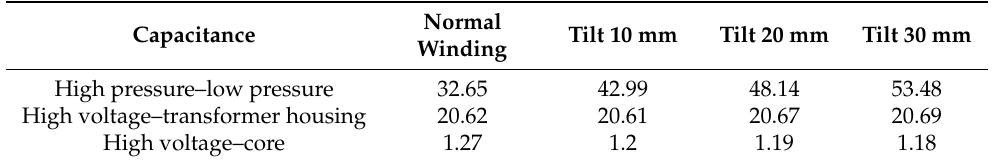
Table 10. Changes in radial capacitance values.